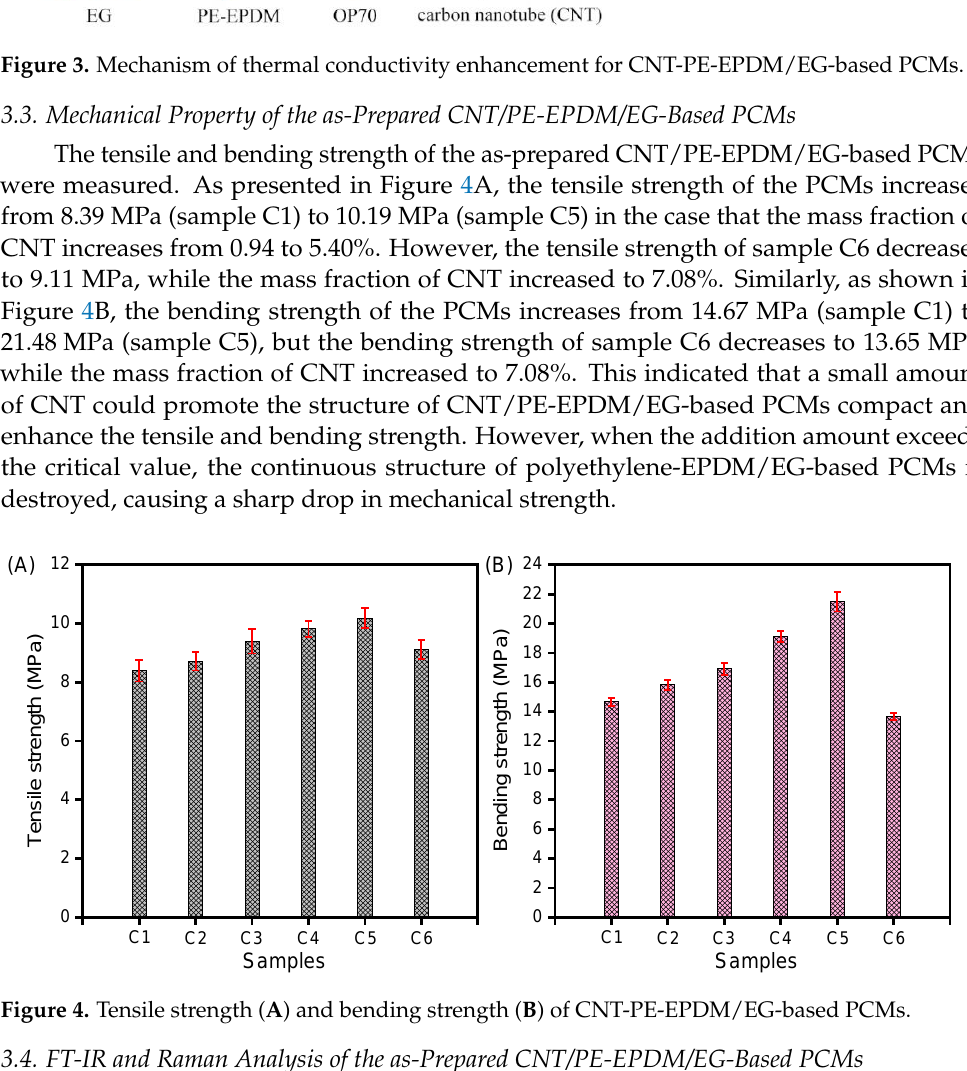
Figure 3. Mechanism of thermal conductivity enhancement for CNT-PE-EPDM/EG-based PCMs.